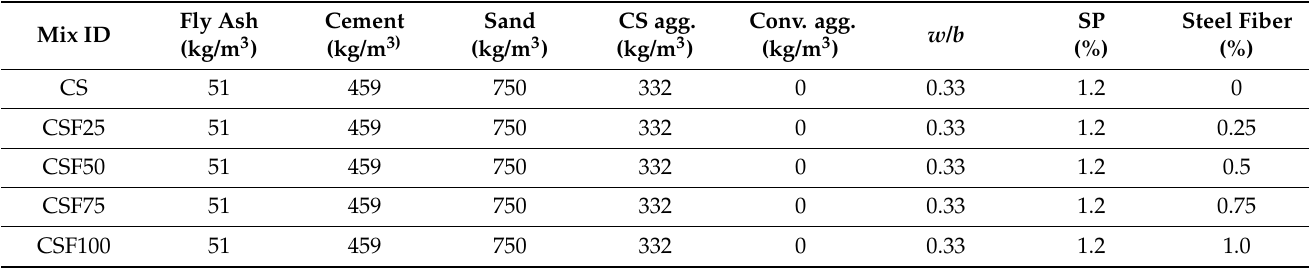
Table 2. The mix Table 2. The mix proportions.